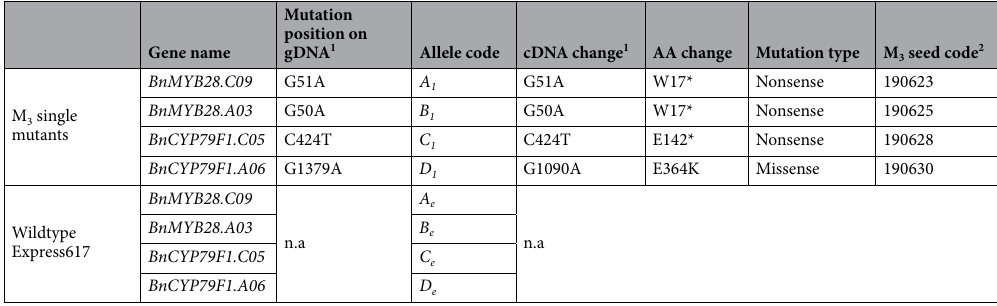
Table 2. Allele codes assigned to EMS mutants and wildtype plants selected as crossing parents in this study. Single mutants were selected as crossing parents to combine single mutations for enhanced phenotypic effects. For each of the analyzed paralogs, mutants and wildtype parents were assigned unique allele codes. 1 Position relative to the translation start site. 2 M 3 seed codes corresponding to screened M 2 mutants. Non-mutated wildtype alleles from Express617 are represented with the ‘e’ suffix in subscript. *Premature stop codon, n.a not applicable.